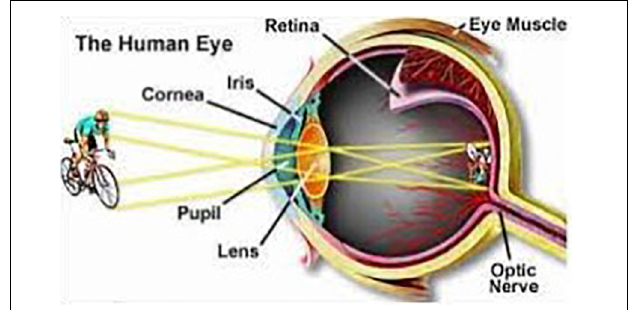
FIGURE 7 | A diagram that comprises both realistic and abstract elements.